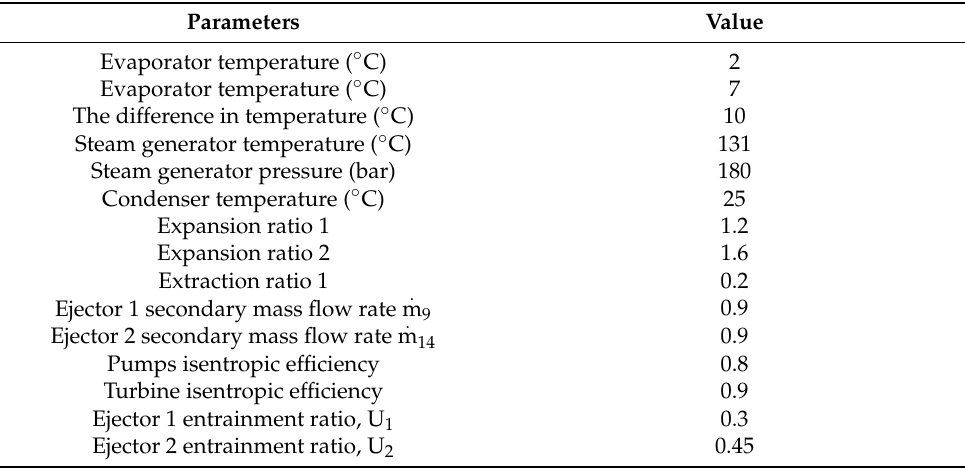
Figure 8. Hourly variation in energy efficiency and net power output. The simulation results of the CMCP system were evaluated on June 21st, at 1.55 p.m. Table 9. Operating conditions for the base case. The thermodynamic, exergetic, and exergoeconomic aspects at all the state points of the cycle using CO 2 were computed using the computer program. Tables 10 and 11 show the main performance indicators, thermodynamic and exergetic properties, as well as the unit cost of exergy flow at the various state points of the proposed system. Table 10. The indicators of the solar-based cogeneration system performance.